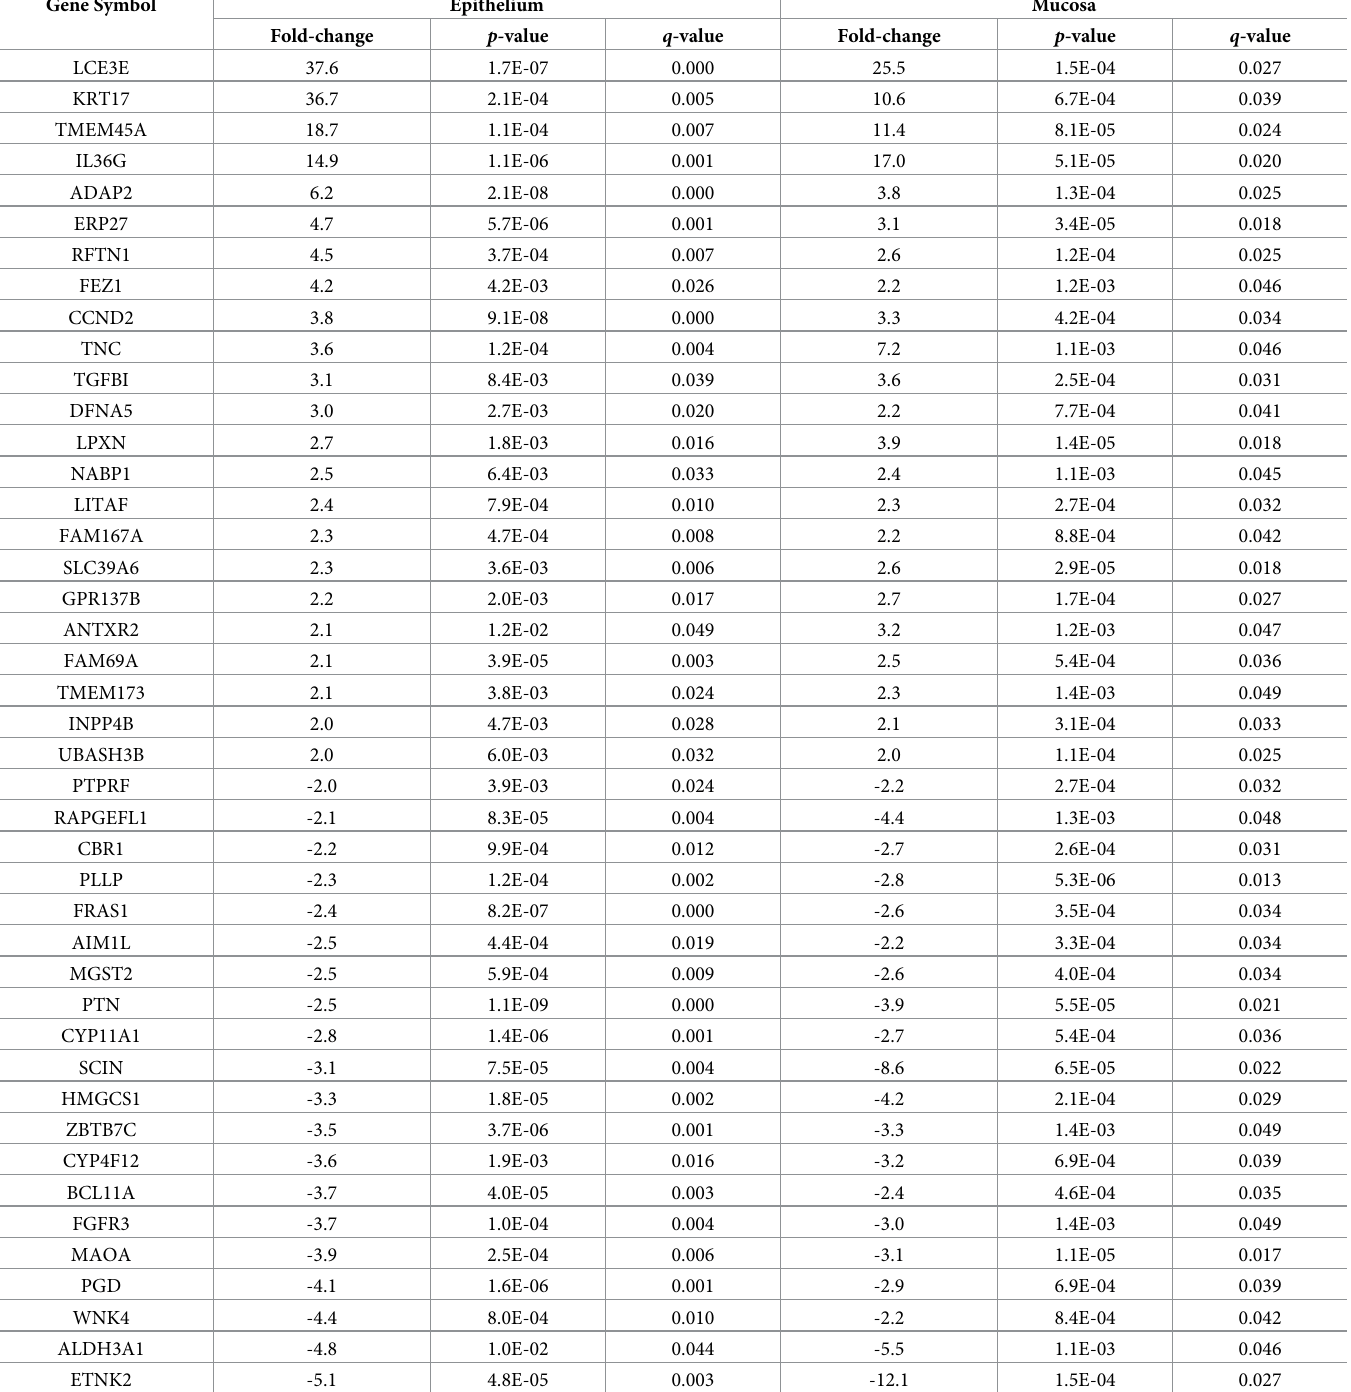
Table 1. Overlapping DEGs between two partial data sets of epithelium and